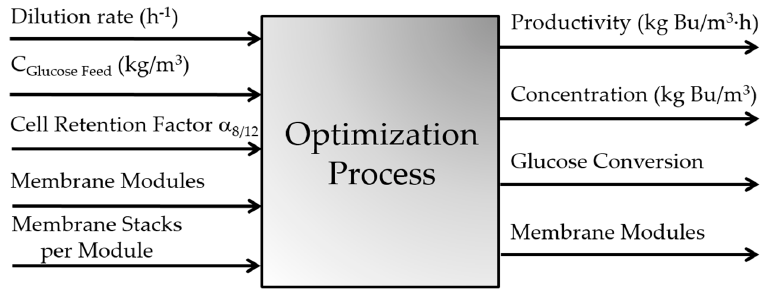
Figure 2. Decision variables and objective functions defining the optimization process of the integrated biobutanol production process. biobutanol production